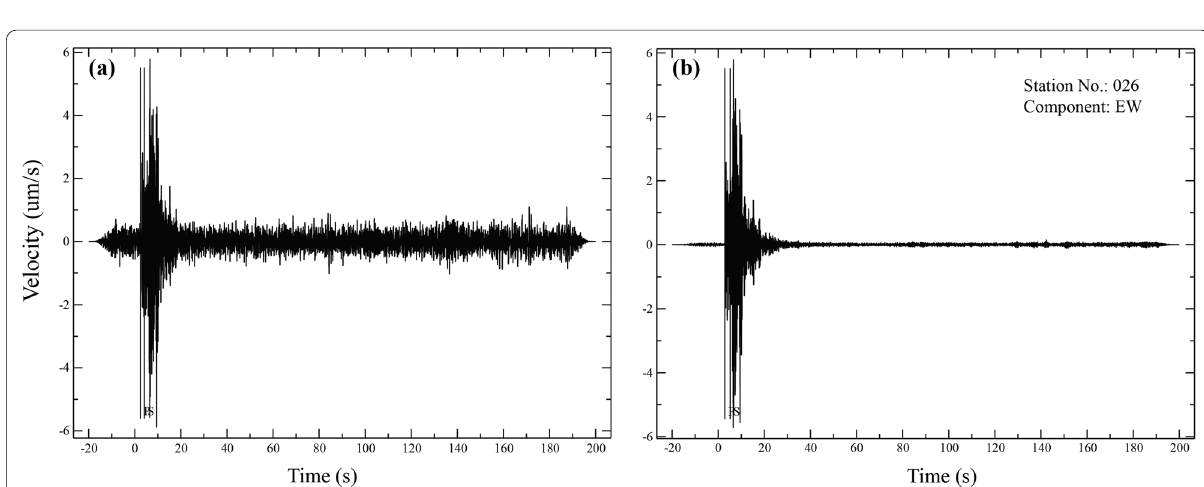
Fig. 2 Comparison of the waveform a before stacking and b after stacking. It shows the EW component of station 26, with the vertical axis representing velocity in um/s and the horizontal axis indicates time in